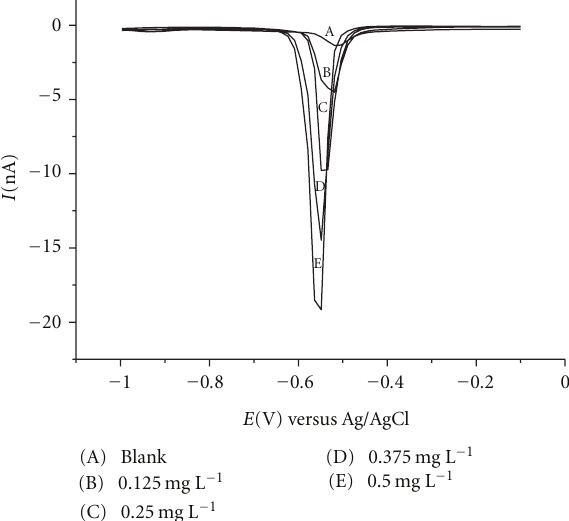
Figure 3: Square-wave voltammograms for di ff erent elemental sulphur concentrations in a bu ff er solution containing 2% (v/v) glacial acetic acid and 1.4mol L − 1 sodium acetate in methanol.